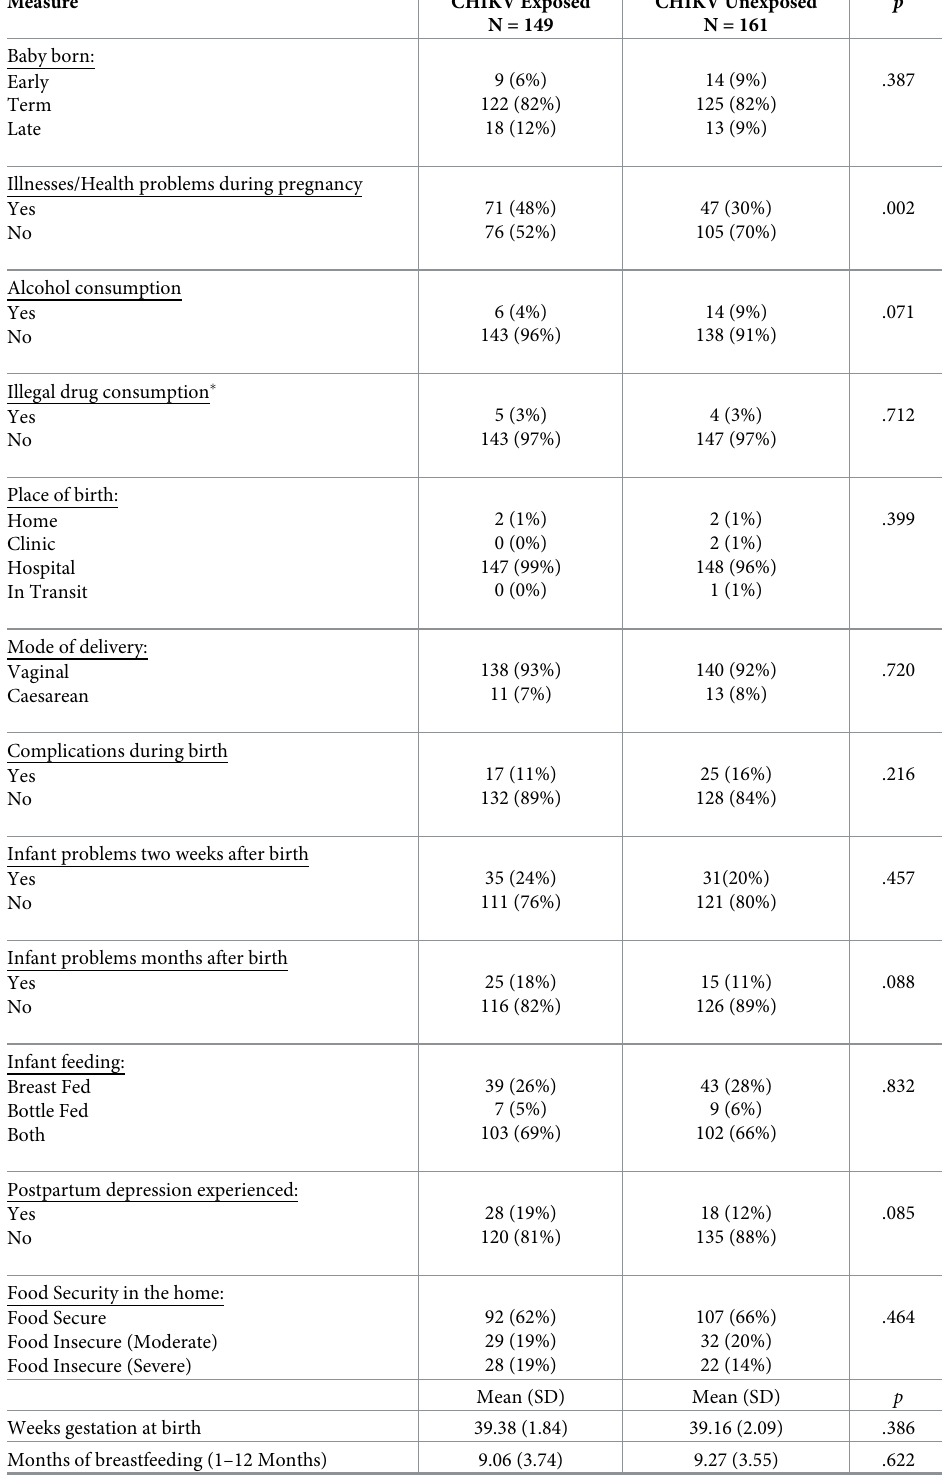
Table 3. Comparison of pregnancy, maternal health, home, and environmental factors by maternal infection status.